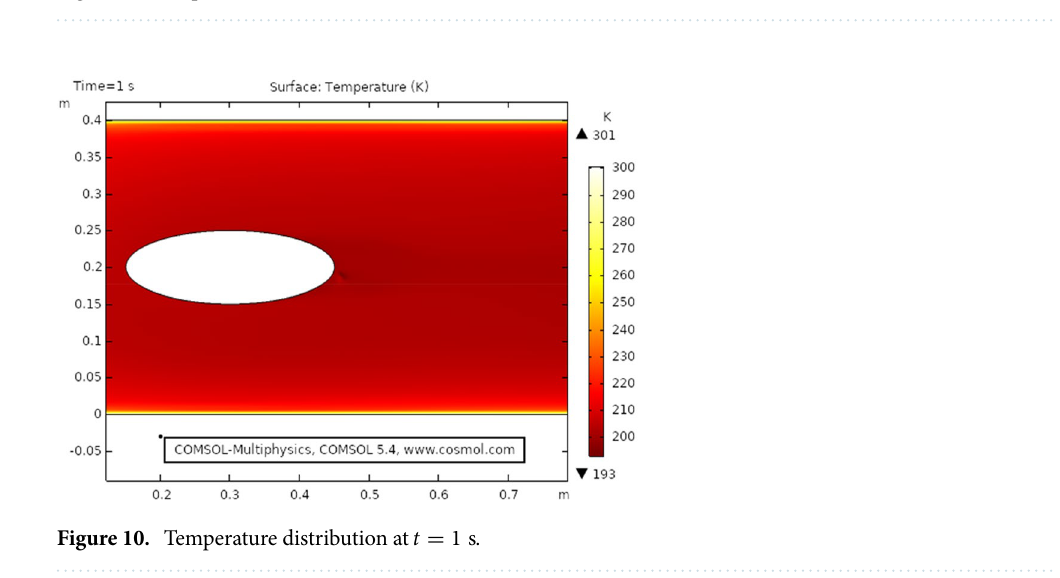
Figure 9. Temperature distribution at t = 3 s .